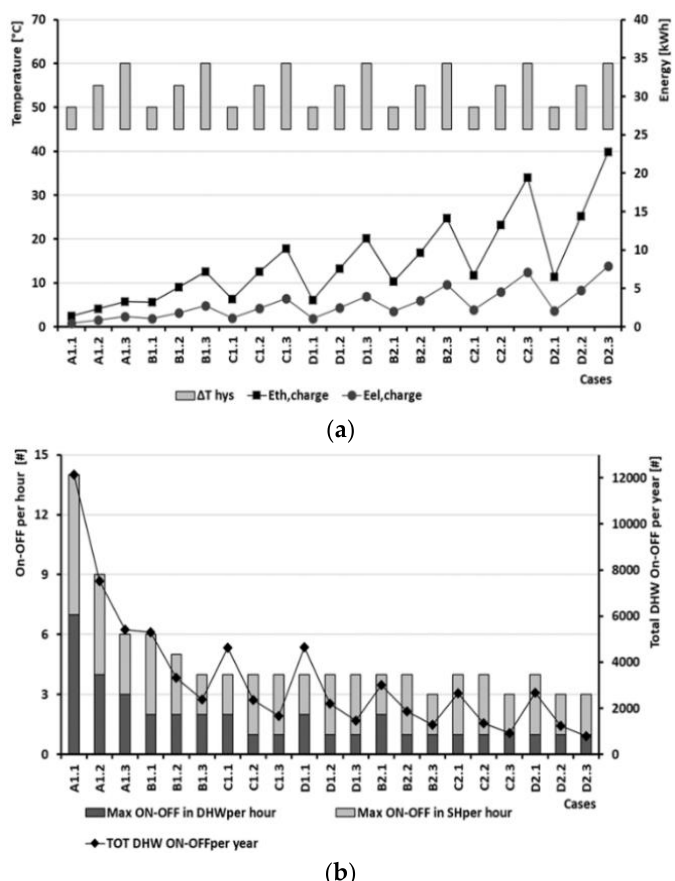
Figure 11. Results of the parametric simulations: ( a ) ETS performance vs. average temperature of the TES and ( b ) relative height of the sensor vs. discomfort percentage.